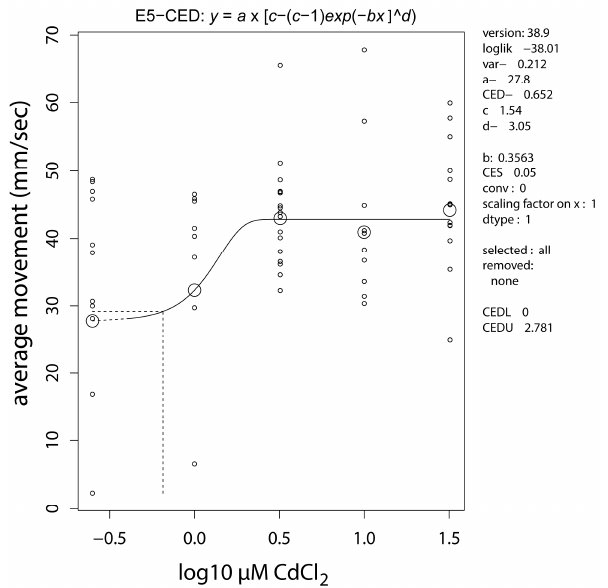
Figure 3. Dose-response analysis of average movement of embryonically cadmium exposed, adult zebrafish. The modelled response shows an increase of 54% at the plateau (c-parameter). A 5% increase (CES = 0.05) is calculated at the critical effect dose (CED) of 0.65 μ M CdCl 2 . Small circles, individual measurements; large circles, median values per concentration.